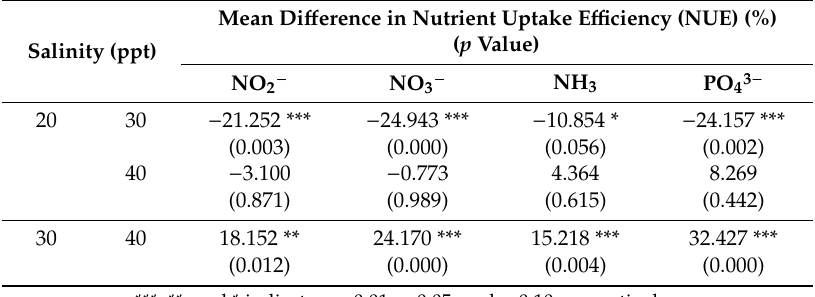
Table 3. Tukey’s HSD results across three di ff erent salinity